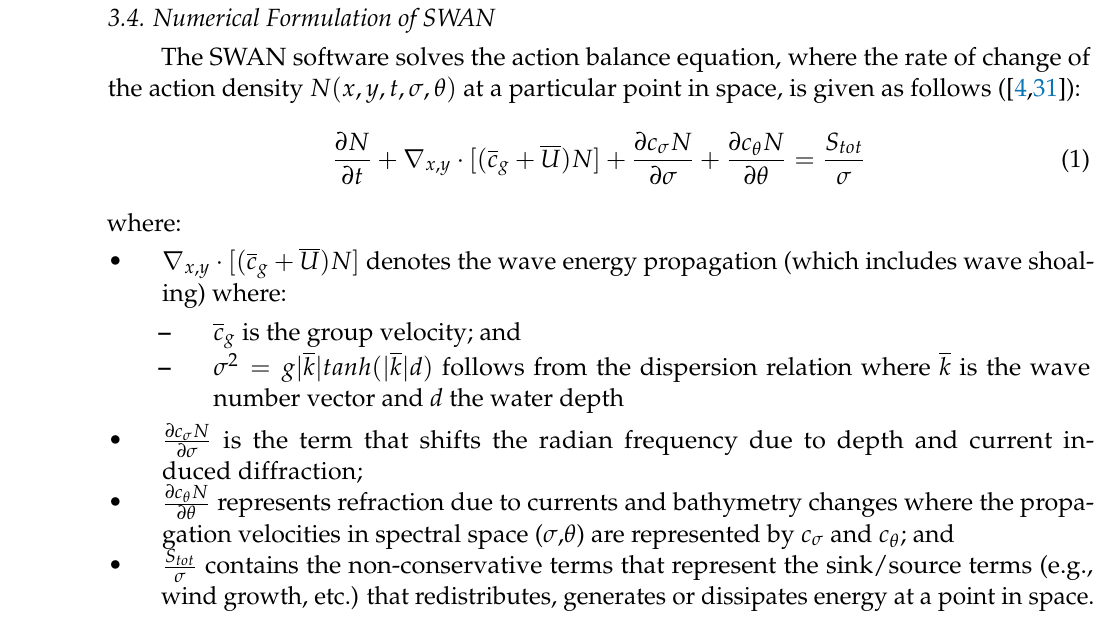
Figure 2. Map of observation stations located throughout the Belgian Continental